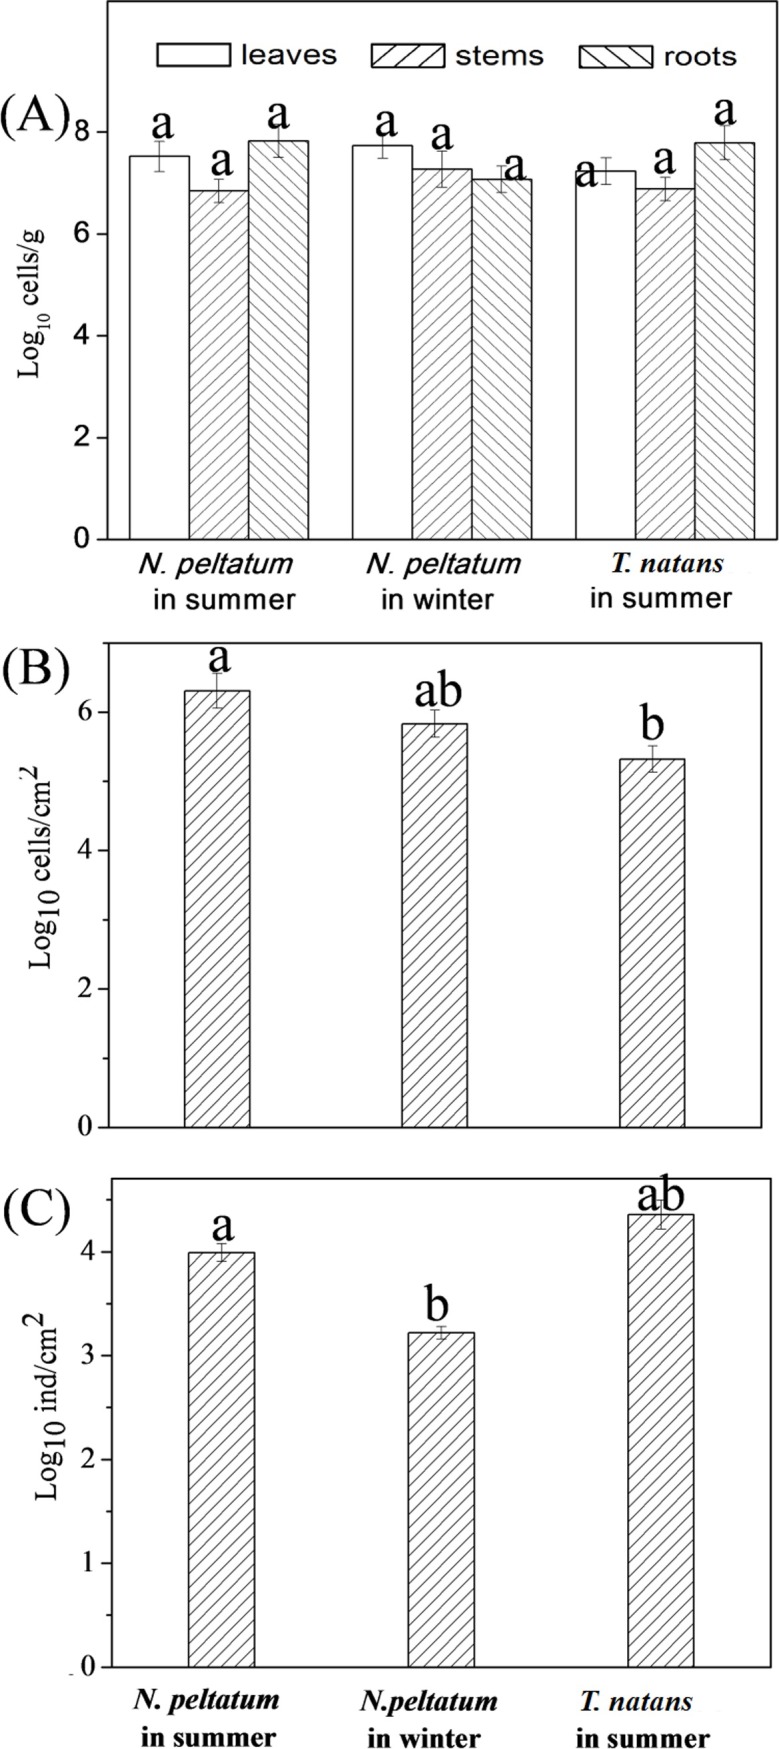
Total densities of bacteria and algae on the leaf, stem and root samples (A, expressed as log10
g-1
dry mass) and densities of bacteria (B, expressed as log10
cells cm-2) and algae (C, expressed as log10
cells cm-2) on the three leaf samples. Different small letters (a, b or ab) indicate significant differences among samples at p < 0.05 (Tukey’s test).